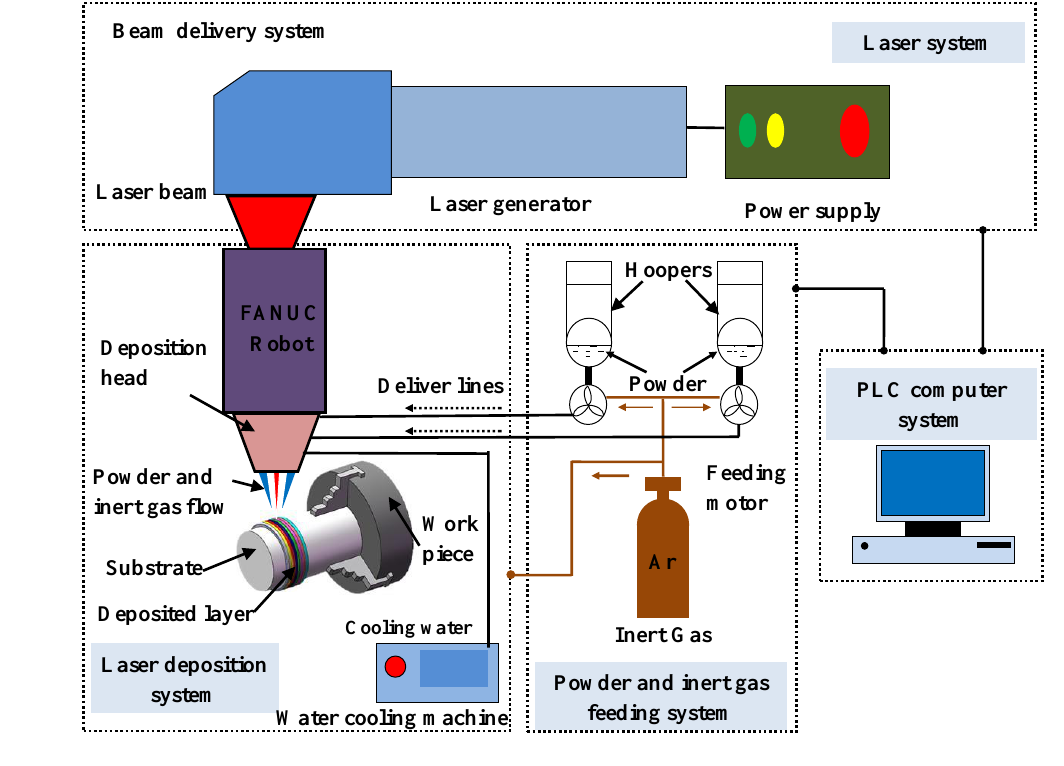
Figure 2. Laser cladding system. Table 3. Purity information about shielding argon